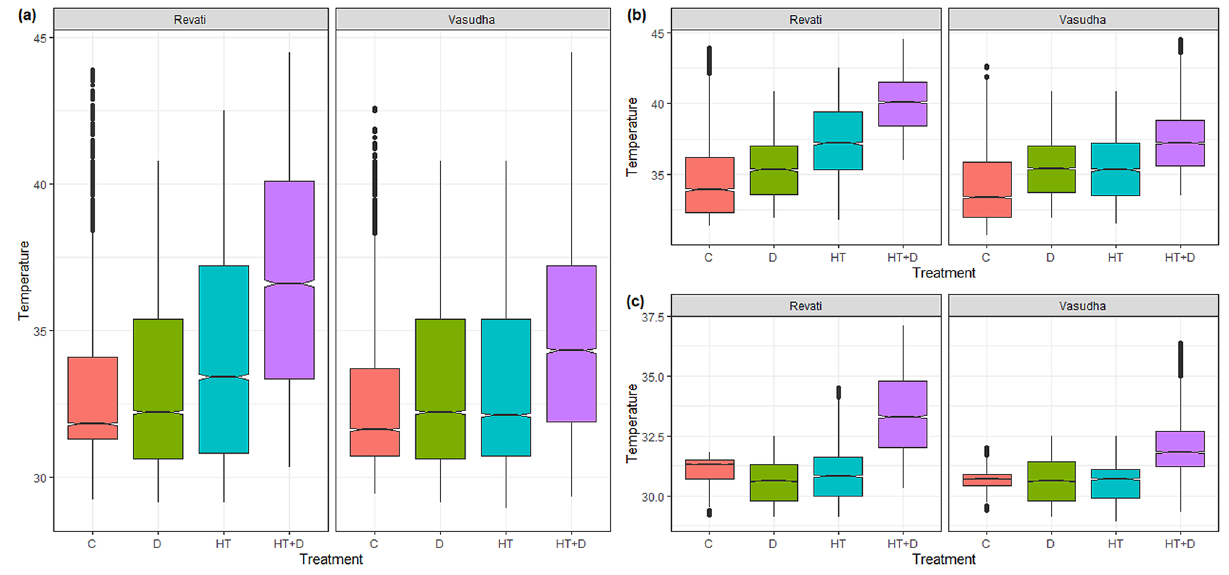
Figure 2. Canopy temperature of Phule Revati and Phule Vasudha under control (C), drought (D), heat (HT), and heat + drought (HT + D) stress at ( a ) analyzed values of all the pixels ( b ) hot pixels and ( c ) cool pixels of the segmented images of plants as explained in material and methods. Each box indicates the interquartile range of canopy temperature under a particular treatment, with the horizontal line representing the median. The notch displays the confidence interval around the median and if the notches of two boxes do not overlap, it indicates the significant difference (P < 0.05).